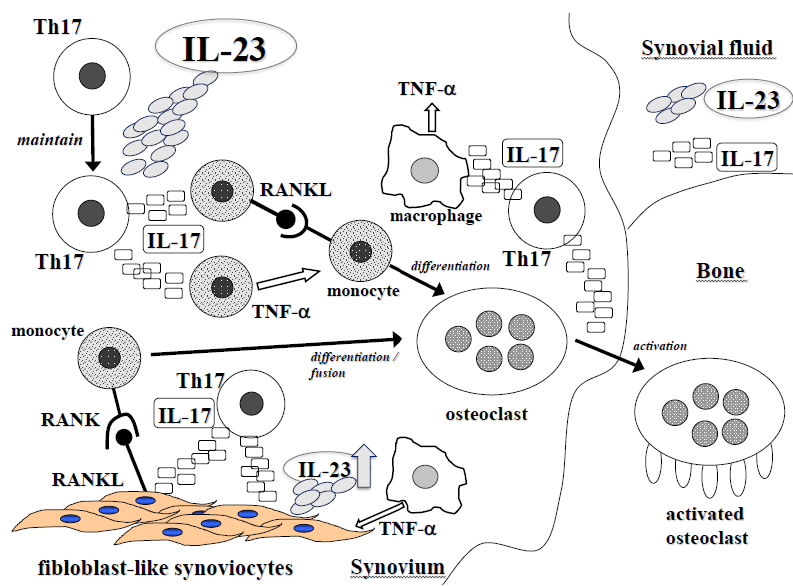
Figure 1. The role of IL-23 in inflammatory arthritis including RA and SpA. IL-23 maintains T17 cells and stimulates IL-17 production. IL-17 induced by IL-23 increases the production of inflammatory mediators such as TNF- α . Furthermore, IL-17 induced by IL-23 up-regulates the expression of RANKL. TNF- α and RANKL cooperates osteoclastogenesis synergistically. The expression of IL-23 is up-regulated by IL-17 and TNF- α .